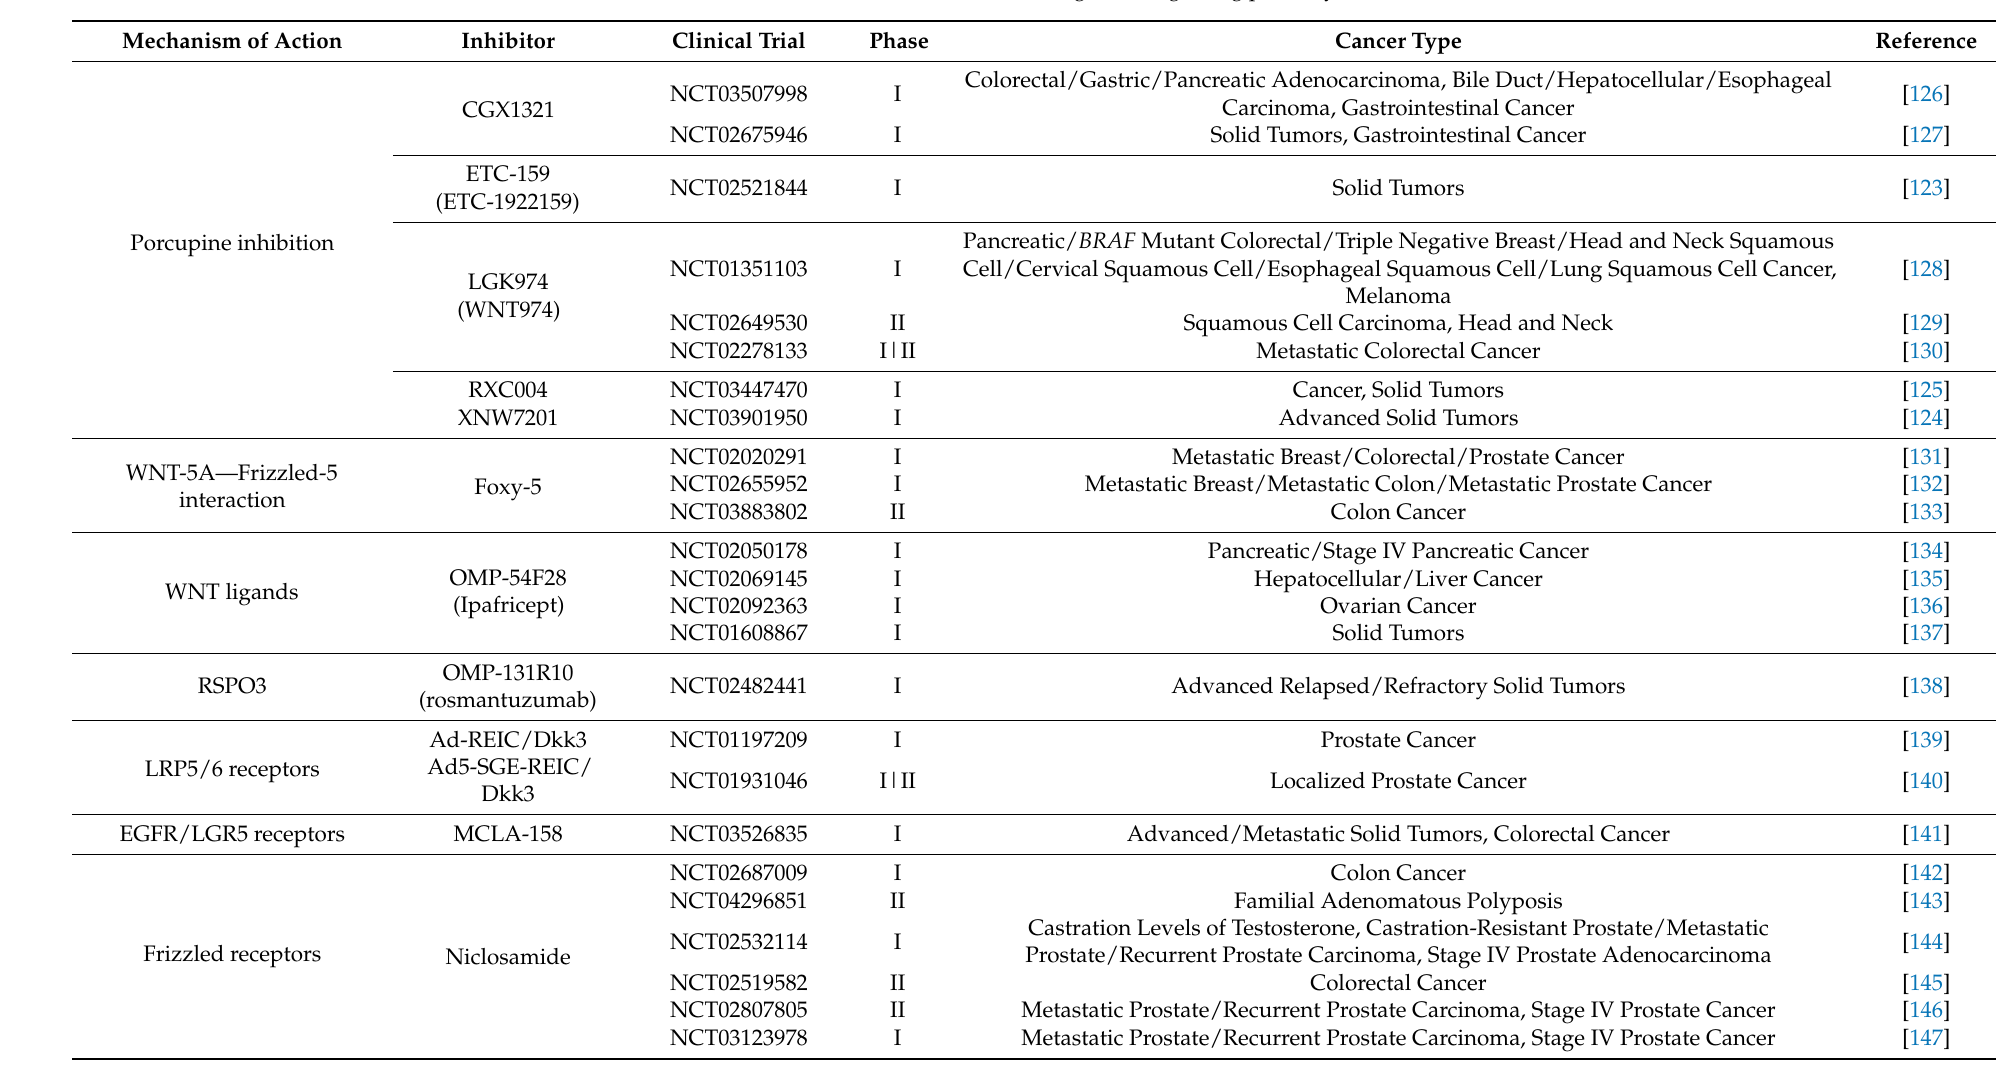
Table 4. Cancer related clinical trials involving WNT signaling pathway